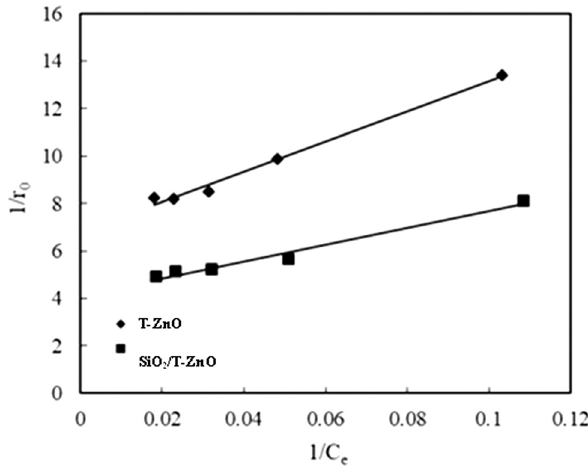
Figure 8: Curves of 1/ C e and 1/ r 0 of